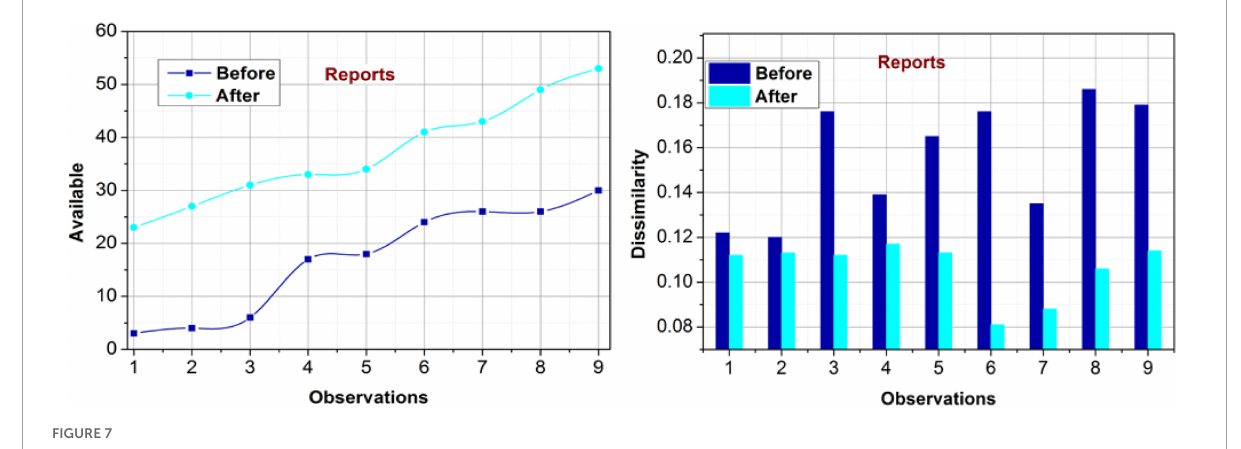
FIGURE7 Availability and dissimilarity (reports).